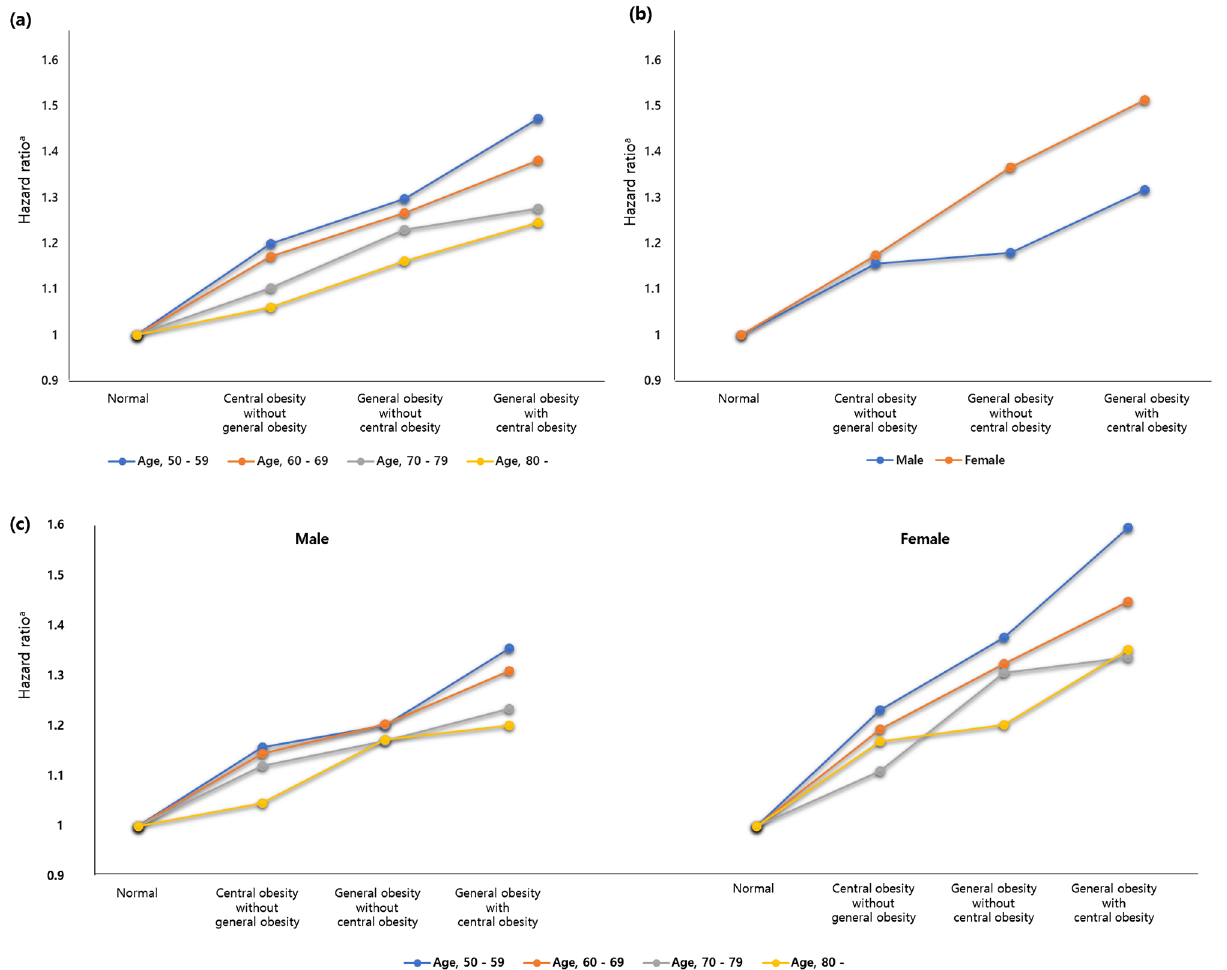
Figure 2. Adjusted knee OA risk for general and/or central obesity composition, according to ( a ) age, ( b ) sex and ( c ) age and sex. a Adjusted for age, sex, income, smoking, alcohol intake, regular exercises, diabetes, hypertension, dyslipidemia, cancer, end-stage renal disease, chronic obstructive pulmonary disease, stroke, liver cirrhosis, hear failure, dementia and chronic kidney